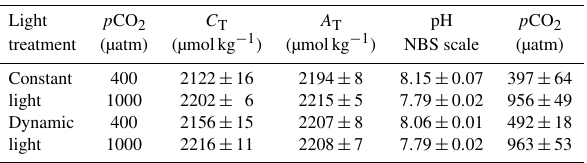
Table 1. Carbonate chemistry measurements for each light and p CO 2 treatment ( n = 4; mean ± 1 SD). The measured values are C T (dissolved inorganic carbon), A T (total alkalinity) and pH (NBS scale). p CO 2 was calculated using the CO2SYS program, with pH and A T as input values. The values were calculated for 2 ◦ C, with a salinity of 32.2. The nutrient levels were 6.5 and 100µmolkg − 1 for PO 4 and Si ( OH ) 4 , respectively. Light p CO